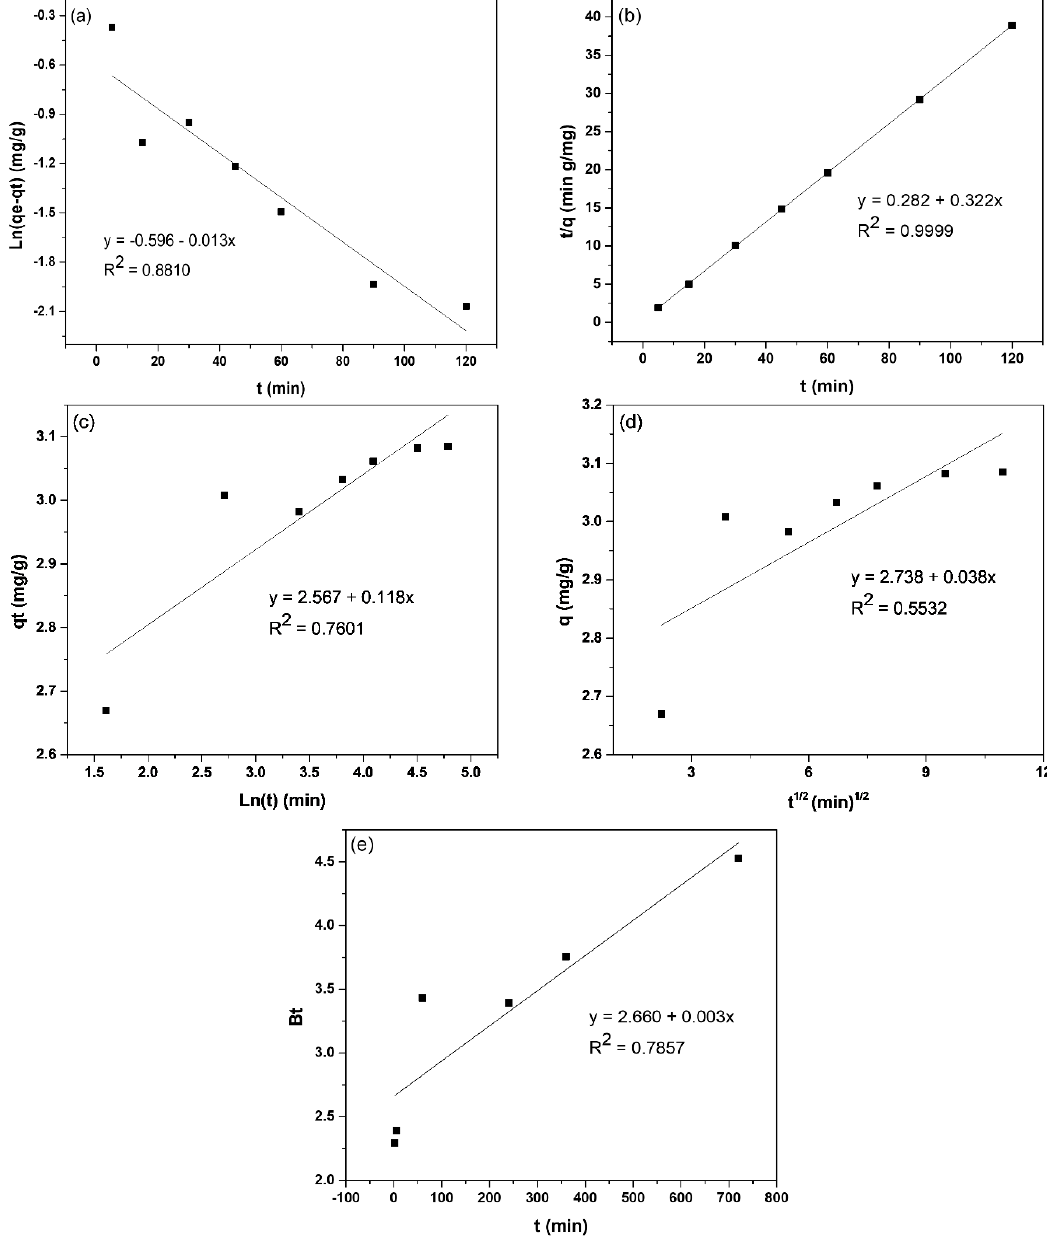
Figure 7. Fittings for SBA-15: ( a ) pseudo-first-order, ( b ) pseudo-second-order, ( c ) Elovich, ( d ) Figure7. FittingsforSBA-15: ( a )pseudo-first-order, ( b )pseudo-second-order, ( c )Elovich, ( d )intraparticle intraparticle diffusion, and ( e ) Boyd models. diffusion, and ( e ) Boyd